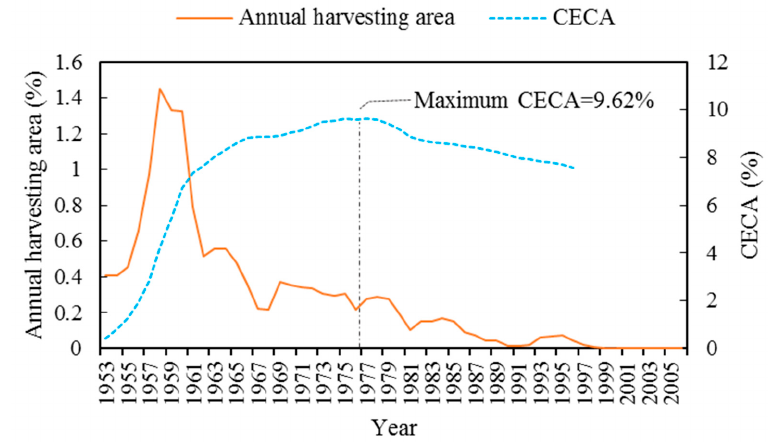
Figure 2. Annual harvesting area from the Miyaluo forest station from 1953–2006 and cumulative equivalent clear-cut area (CECA) in the Upper Zagunao River watershed from 1953–1997 [47].